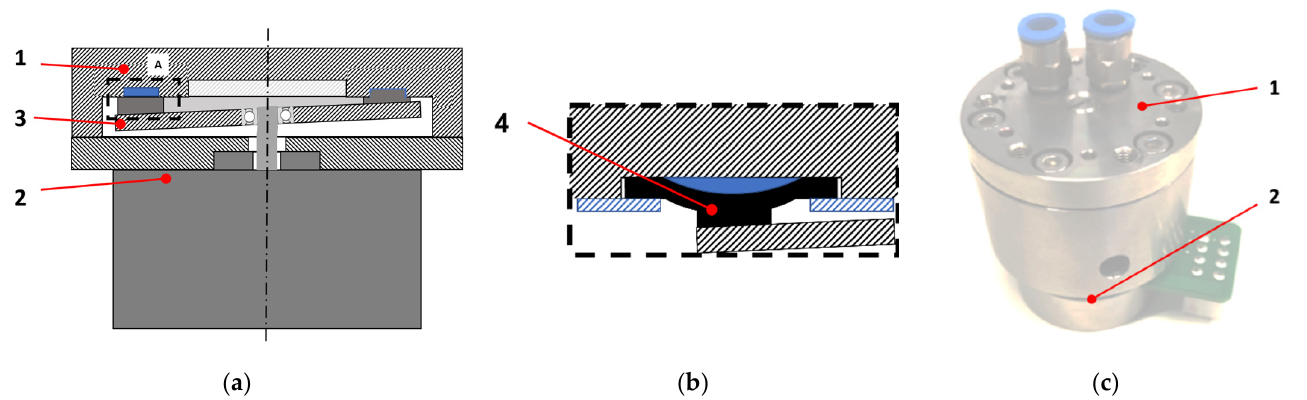
Figure 3. Design of the micro-dosing pump, pump itself (1), primary drive with transmission gear (2) and the non-rotating wobble plate (3) with the soft material layer on top which forms the cavity together with the housing; ( a ) Cross-section view of the schematic illustration; ( b ) detailed cross-section of the rubber (4) and cavity; ( c ) picture of the prototype.